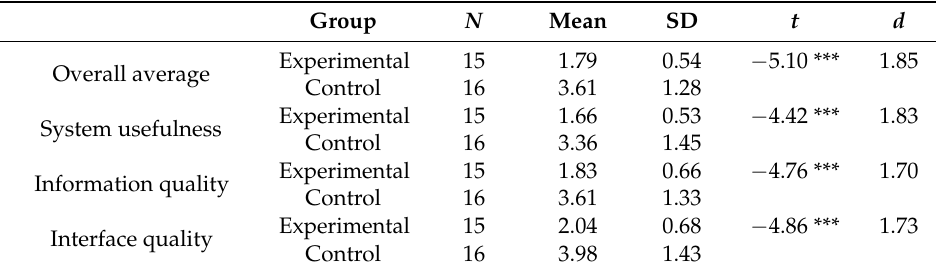
Table 5. Independent sample t -test of PSSUQ between the two